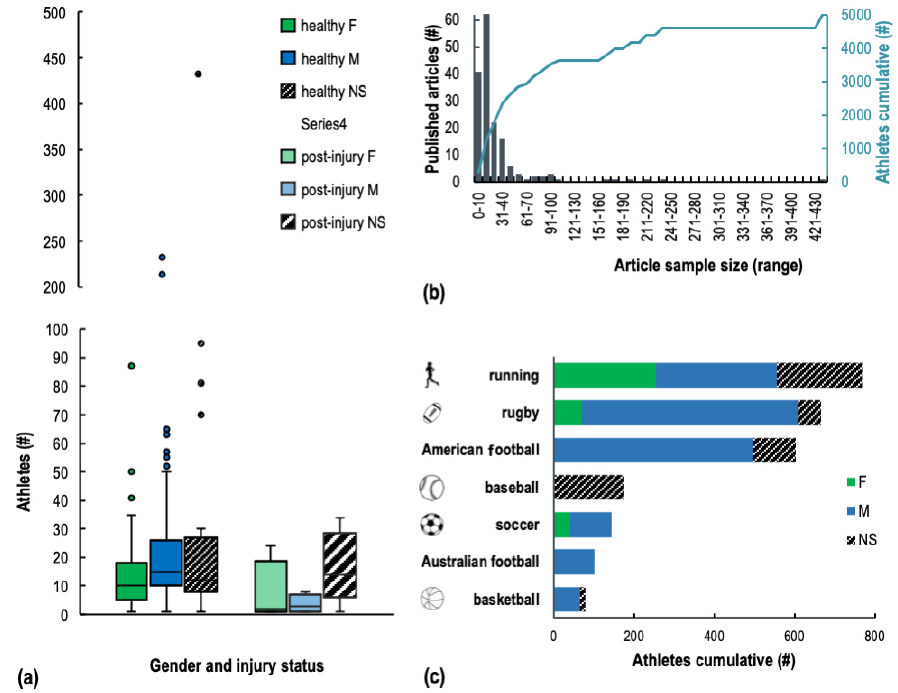
Figure 6. ( a ) Boxplot of healthy and post-injury athletes divided by gender. ( b ) Left: number of athletes analysed in groups of the sample size reported in abscissa; right: their cumulative value. ( c ) Number of athletes, divided by gender, tested in the sports analysed in the 21 studies comprising half of the overall sample of this review (F = females, M = males, NS = gender not specified).